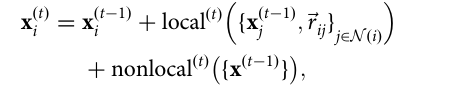
Fig. 1 Main features of SpookyNet and problems addressed in this work. a Optimized geometries of Ag þ Without information about the electronic state (charge/spin), machine learning models are unable to distinguish between the different structures. b Au 2 dimer on a MgO(001) surface doped with Al atoms (Au: yellow, Mg: gray, O: red, Al: pink). The presence of Al atoms in the crystal in fl uences the electronic structure and affects Au 2 binding to the surface, an effect which cannot be adequately described by only local interactions. c Potential energy E pot (solid black) for O – H bond dissociation in water. The asymptotic behavior of E pot for very small and very large bond lengths can be well-approximated by analytical short-ranged E sr (dotted red) and long-ranged E lr (dotted orange) energy contributions, which follow known physical laws. When they are subtracted from E pot , the remaining energy (solid blue) covers a smaller range of values and decays to zero quicker, which simpli fi es the learning problem. d Visualization of a random selection of learned interaction functions for SpookyNet trained on the QM7-X 71 dataset. They are designed to closely resemble atomic orbitals, facilitating SpookyNet ’ s ability to extract chemical insight from